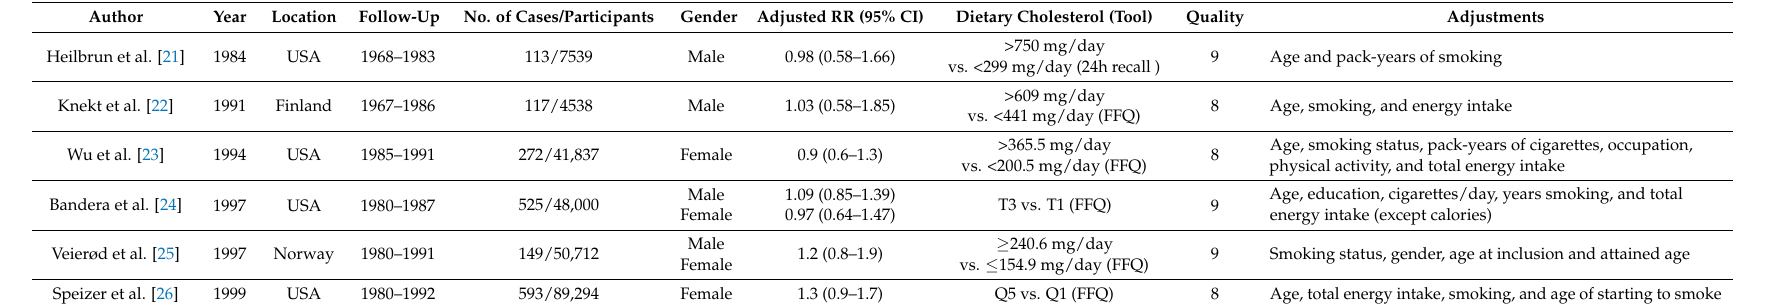
Table 2. Cohort studies included in the